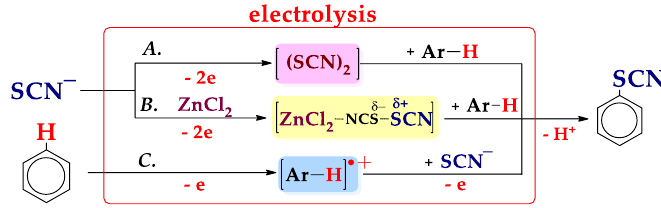
Figure 1. CV curves on Pt working electrode in 0.1M NaClO 4 in MeCN, = 0.10 V ‧ s −1 . ( А ) NH 4 SCN (0.002M) — 1; 3-methyl-1 H -pyrazol-5-amine 1e (0.002M) — 2; 3-methyl-4-thiocyanato-1 H -pyrazol-5-amine 1f (0.002M) — 3; mixture NH 4 SCN/azole 1e (1:1) with the reverse scan from 0.60 V — 4; the same on the reverse scan from 1.45V — 5; ( B ) NH 4 SCN (0.002M) — 1; 10e (1:1) on the reverse scan from 1.20 V — 4; the same on the reverse scan from 2.10 V — 5.